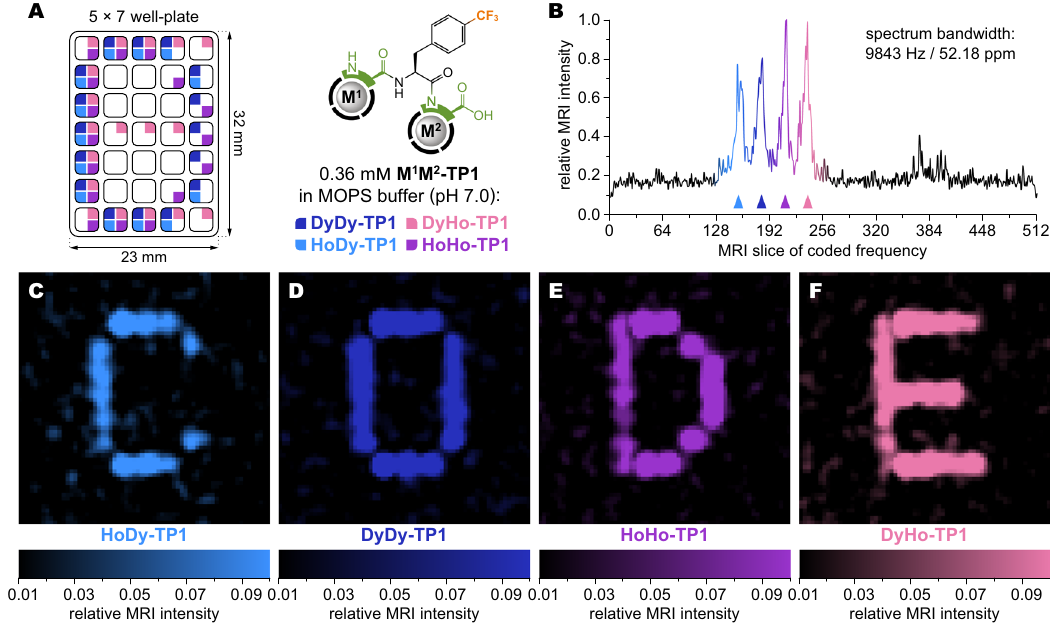
Fig. 9 Image encoding and reading with 19 F MRI (4.7 T). A Distribution pattern of M 1 M 2 -TP1 compounds encoded with Dy 3 + /Ho 3 + ions within a 7 × 5- well plate ( fi nal concentrations ∼ 0.36 mM each compound, well volumes completed to 75 μ L with water). B 19 F MR spectrum obtained from the entire well plate shows four distinct peaks of the four encoded compounds (marked with triangles, color-coding as explained in A). The spectrum was created by projecting the maximum signal intensity from each slice of (CSI) MRI data onto the frequency dimension. The spectral resolution was 19.2 Hz (0.10 ppm) per slice. C – F Selective display of HoDy-TP1 ( C ), DyDy-TP1 ( D ), HoHo-TP1 ( E ) and DyHo-TP1 ( F ) compounds reveals the patterns encoded with them into the well plate as legible letters (average of 15 adjacent slices for each compound peak). Displayed fi eld of view: 50×50 mm, voxel size 0.78 × 0.78 × 10 mm. Image intensities were mapped to colors as shown in the legends. See also Supplementary Movie 1 for a fl y-through view of the MRI